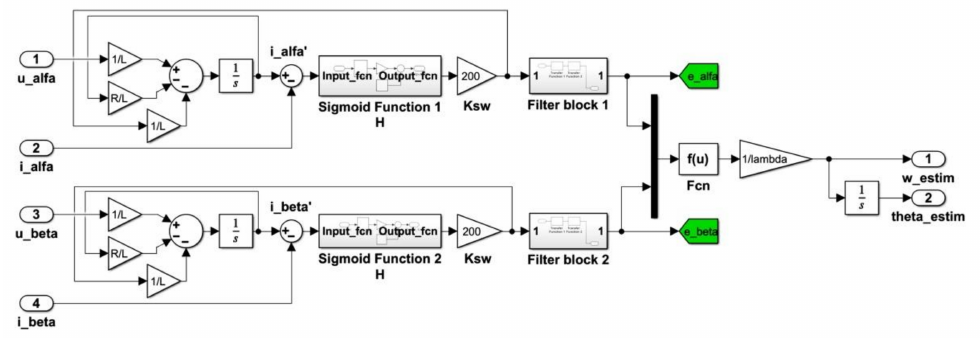
Figure 20. Block diagram of the MATLAB/Simulink implementation for PMSM rotor speed and position